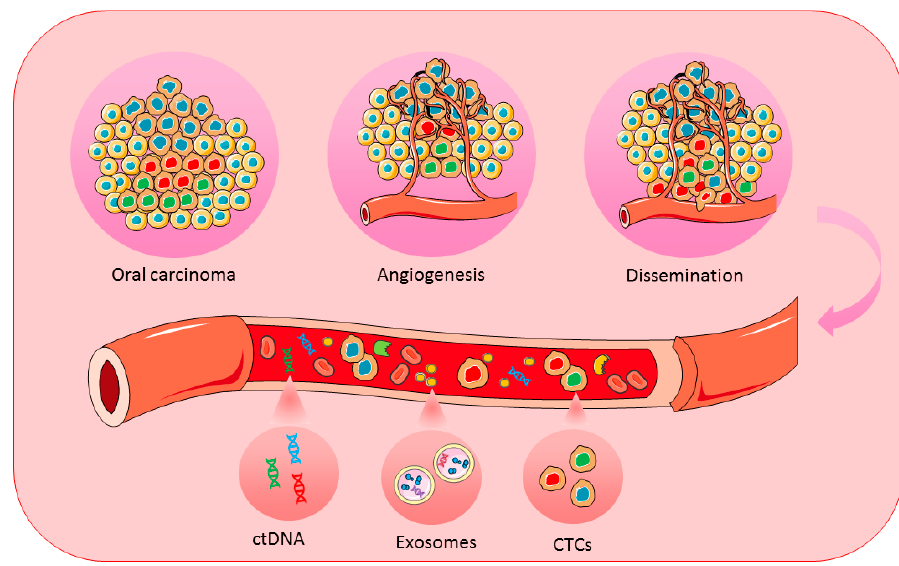
Figure 1. Schematic representation of CTCs, ctDNA, and exosomes for achieving personalized medicine in oral cancer. CTCs, circulating tumour cells; ctDNA, circulating tumour DNA.